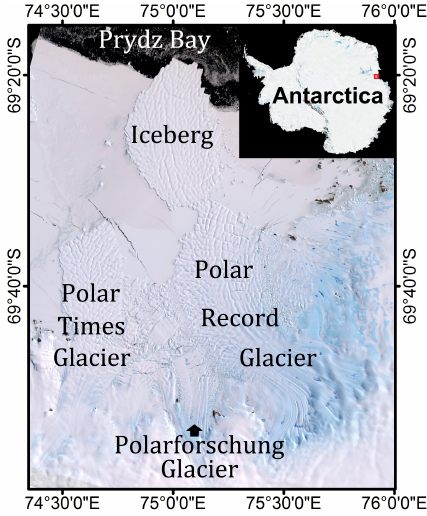
Figure 1. Landsat-7 enhanced thematic mapper plus (ETM+) scan line corrector (SLC)-off image (true color composite) of the Polar Record Glacier (PRG) obtained on 31 January 2009.